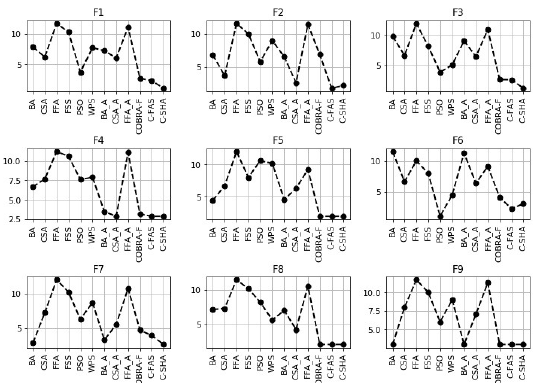
Figure 6. Results of the Friedman statistical test for SET-2 ( D = 10).